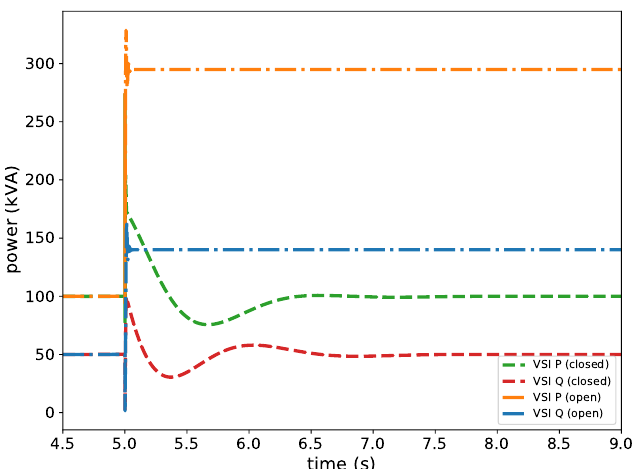
Figure 4. VSI output power transient with an open and closed control